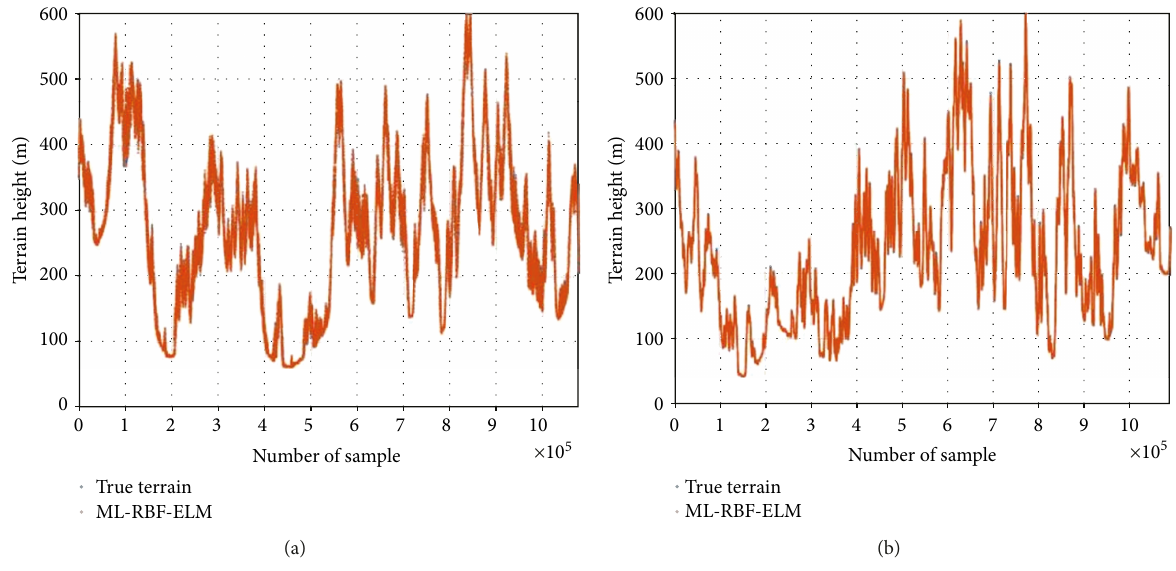
Figure 5: Fitting result of the proposed ML-RBF-ELM. (a) DTED level 3 result. (b) DTED level 2 result.